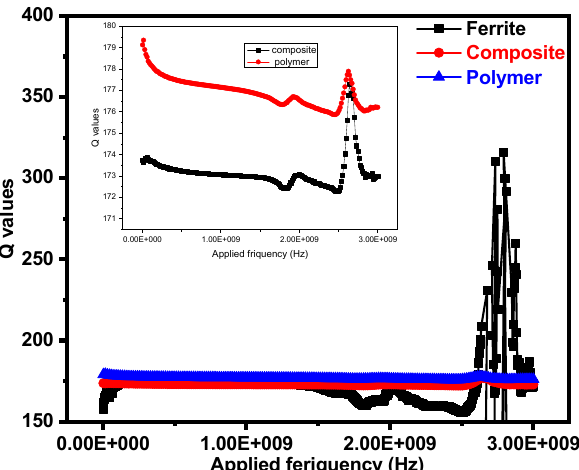
Figure 11. Variation of quality factor (Q) values with the frequency of Y-type hexaferrite Sr 2 Co 2 Fe 12 O 22 , composite (Sr 2 Co 2 Fe 12 O 22 + PPy-DBSA), and polymer PPy-DBSA.